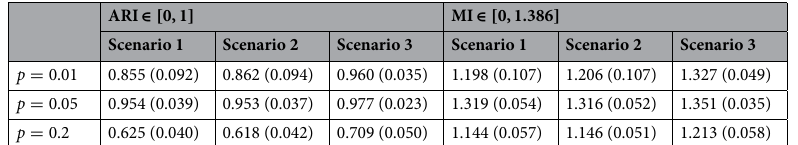
Table 1. Average values of accuracy measures of the Bayes estimator parentheses.